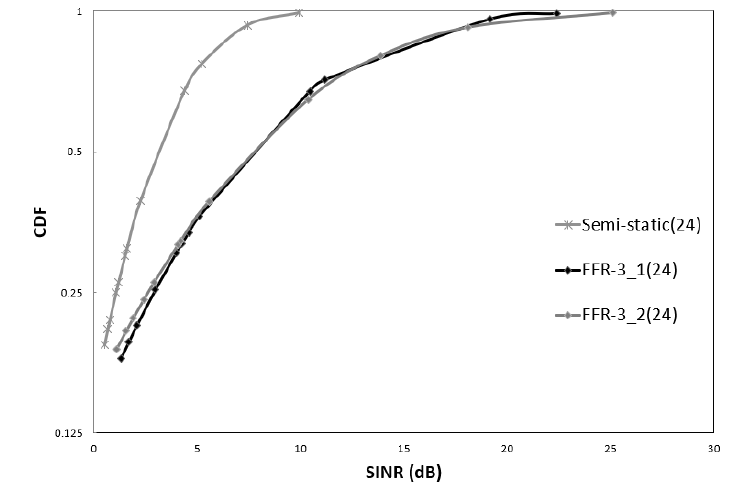
Figure 16. CDF of sensor SINR in D2D link (D2D Tx power = 30 dBm).